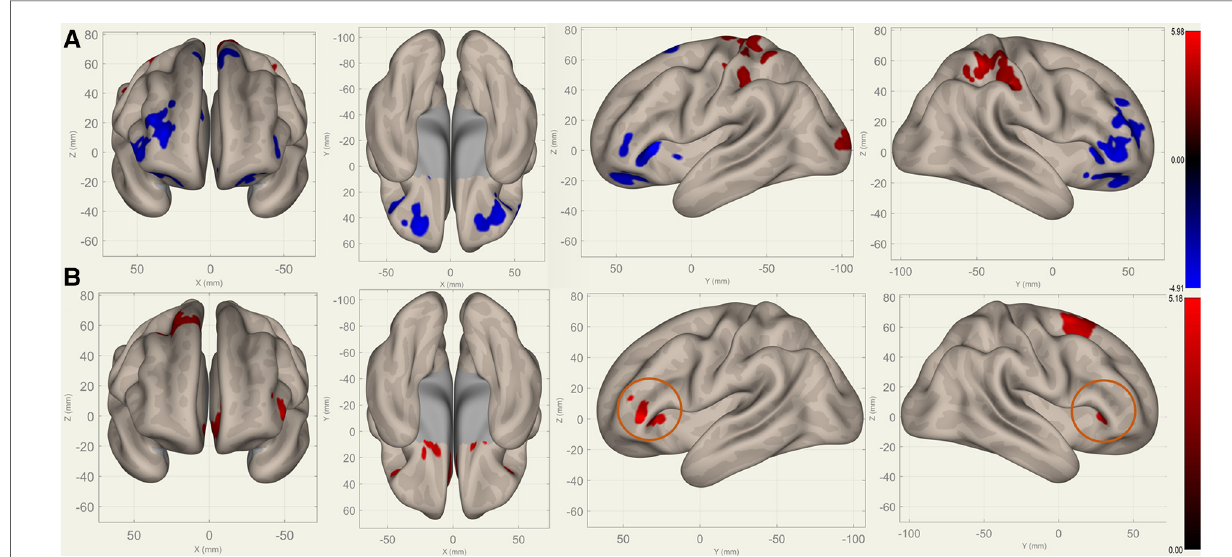
FIGURE 4 Perioperative seed-based connectivity changes in the bilateral putamina (seed points) ( T . 3 : 25, voxel threshold p (cid:1) unc , 0 : 01, cluster threshold p (cid:1) FDR , 0 : 05). ( A ) S1>S0: The decreases were most prominent in the right frontal pole (MNI [ þ 40 þ 36 þ 00], cluster size: 1172 voxels, peak p (cid:1) unc , 0 : 001, size p (cid:1) FDR , 0 : 001), left frontal orbital gyrus (MNI [ (cid:1) 30 þ 40 þ 06], cluster size: 852 voxels, peak p (cid:1) unc , 0 : 001, size p (cid:1) FDR , 0 : 001), and right paracingulate gyrus (MNI [ þ 00 þ 40 þ 34], cluster size: 675 voxels, peak p (cid:1) unc , 0 : 001, size p (cid:1) FDR , 0 : 001). ( B ) S2>S1: The increases were most prominent in the left paracingulate gyrus (MNI [ (cid:1) 18 þ 16 (cid:1) 08], cluster size: 1144 voxels; peak p (cid:1) unc , 0 : 001, size p (cid:1) FDR , 0 : 001) and the right superior frontal gyrus (MNI [ þ 26 þ 10 þ 68], cluster size: 472 voxels; peak p (cid:1) unc , 0 : 001, size p (cid:1) FDR , 0 : 001). The orange circles indicate “ map expansion ” neuroplasticity after the surgery.